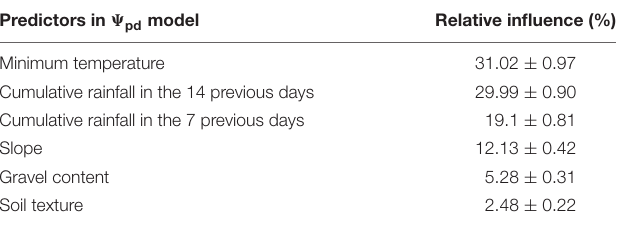
TABLE 5 | Relative influence of predictors in predawn leaf water potential ( (cid:57) pd ) model (scaled so that the sum of all relative contributions is